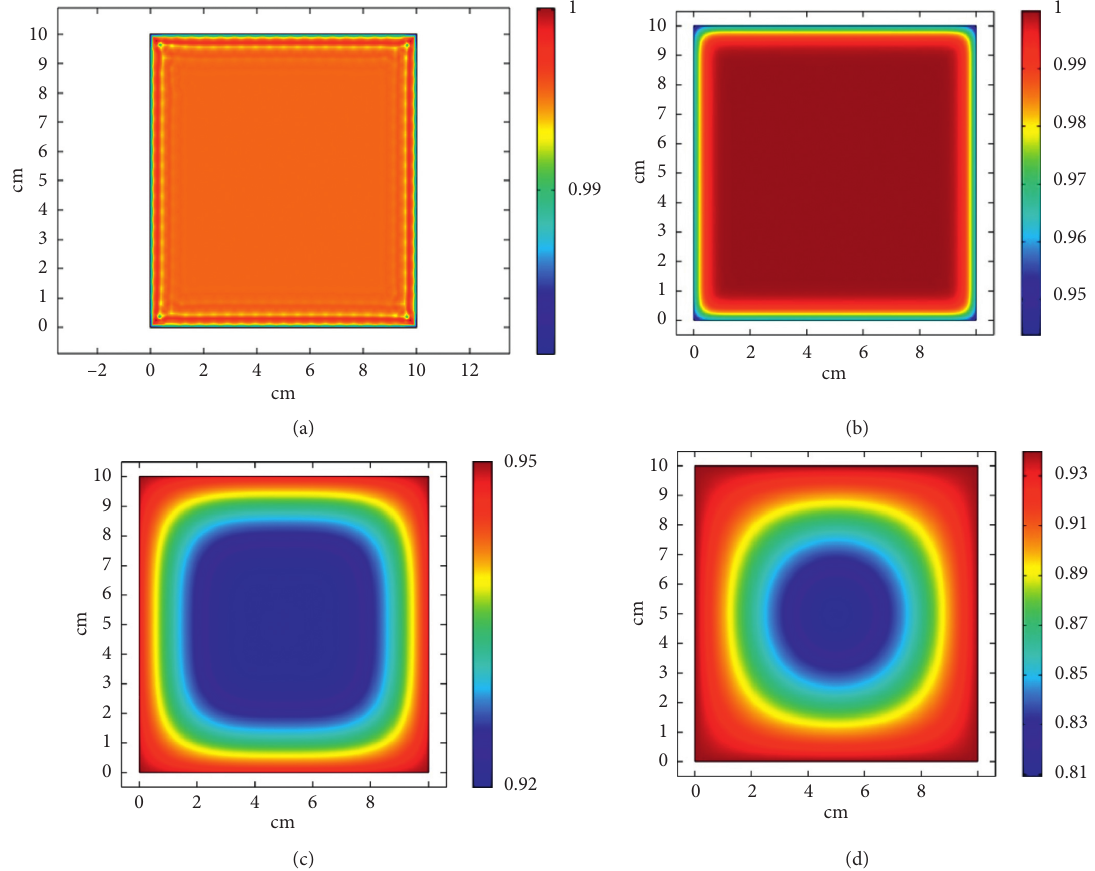
Figure 8: Simulated evolution of internal relative humidity in the CPB sample at different curing ages: (a) 0d; (b) 1d; (c) 23d; (d) 28d.